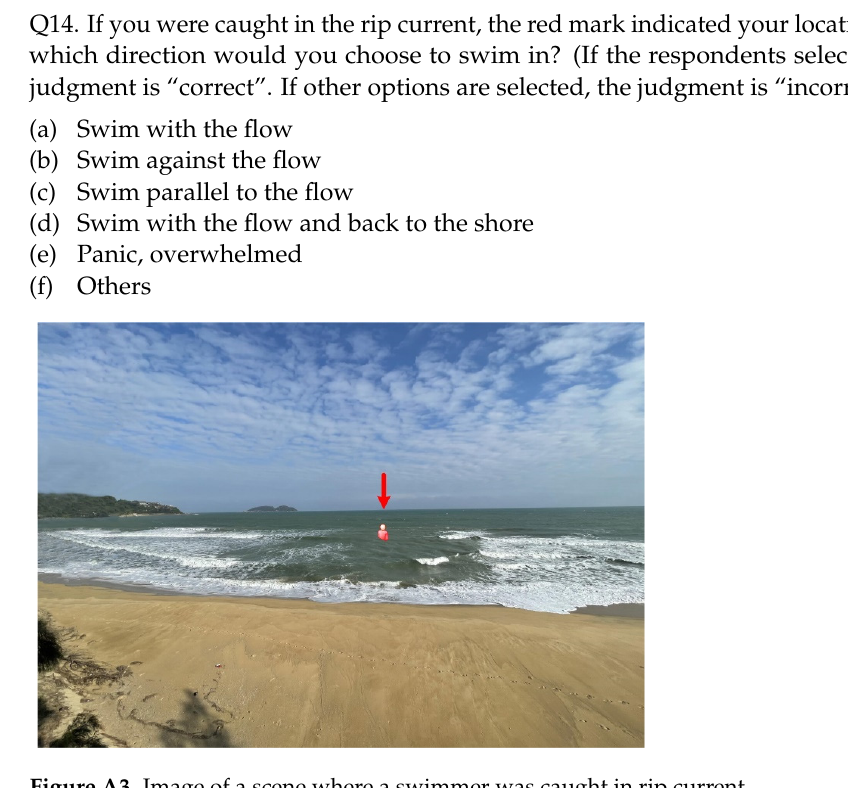
Figure A3. Image of a scene where a swimmer was caught in rip current.